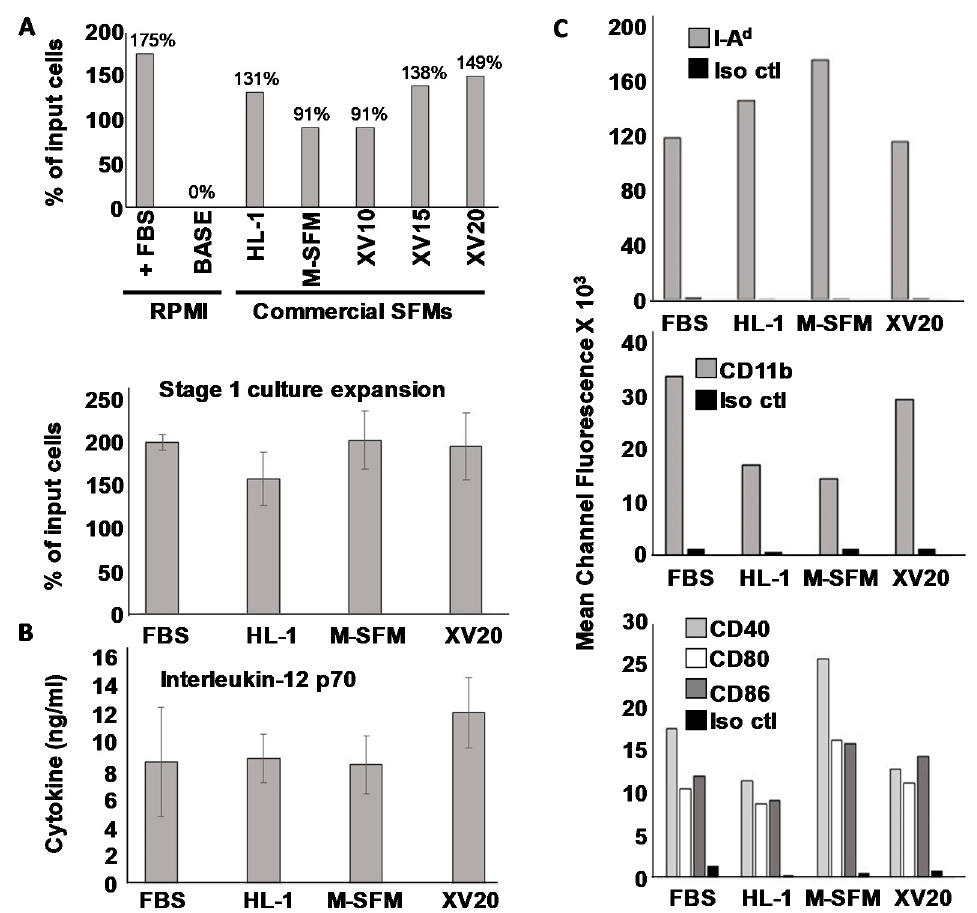
Figure 1. Characterization of DC phenotype. ( A ) One-time screen of seven different culture conditions for stage I DC culture with cells from murine bone marrow aspirates maintained for 6 days in indicated media supplemented with Flt/3 ligand and IL-6, then harvested and viable cell numbers determined using Trypan Blue dye exclusion. Percent expansion based on initial input cells was calculated (upper panel). Statistical analysis of stage I expansion of bone marrow cells from three separate experiments using four selected culture media (lower panel. ( B ) ELISA analysis for IL-12p70 of culture supernatants after stage II culture in GM-CSF and IL-4 followed by activation with ODN-1826 and LPS ( C ) Flow cytometry analysis of surface phenotype of cells 24 h after activation.